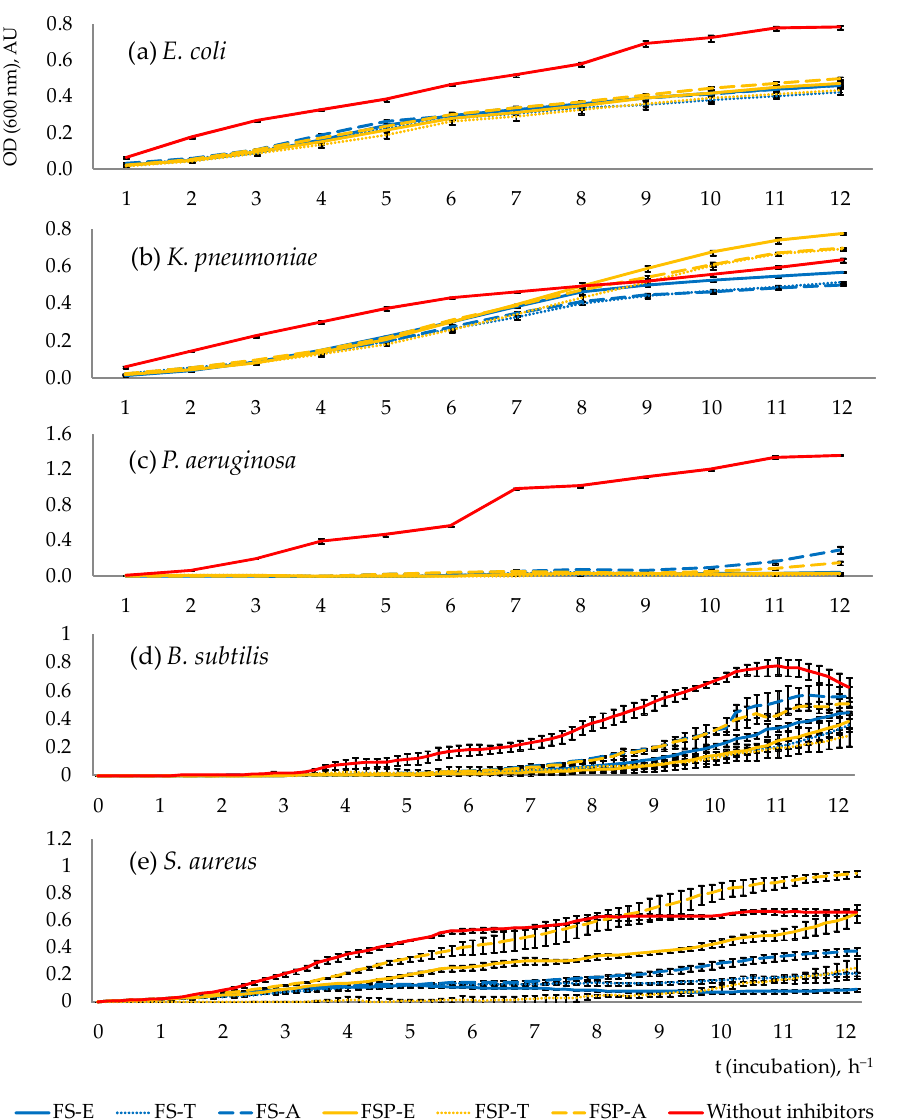
Figure 2. Growth dynamics of E. coli ( a ), K. pneumoniae ( b ), P. aeruginosa ( c ), B. subtilis ( d ) and S. aureus ( e ) in a 12 h inhibition test. Error bars represent the standard deviation of optical density at 600 nm of at least three independent wells ( n = 3); AU- absorbance units; FS-E, FS-T, FS-A—filter- sterilised fermentates of PAB strains Propionibacterium freudenreichii (E), Acidipropionibacterium thoenii (T) and Acidipropionibacterium acidipropionici (A); FSP-E, FSP-T, FSP-A—filter-sterilised and treated with proteinase K fermentates obtained from the respective PAB strains.